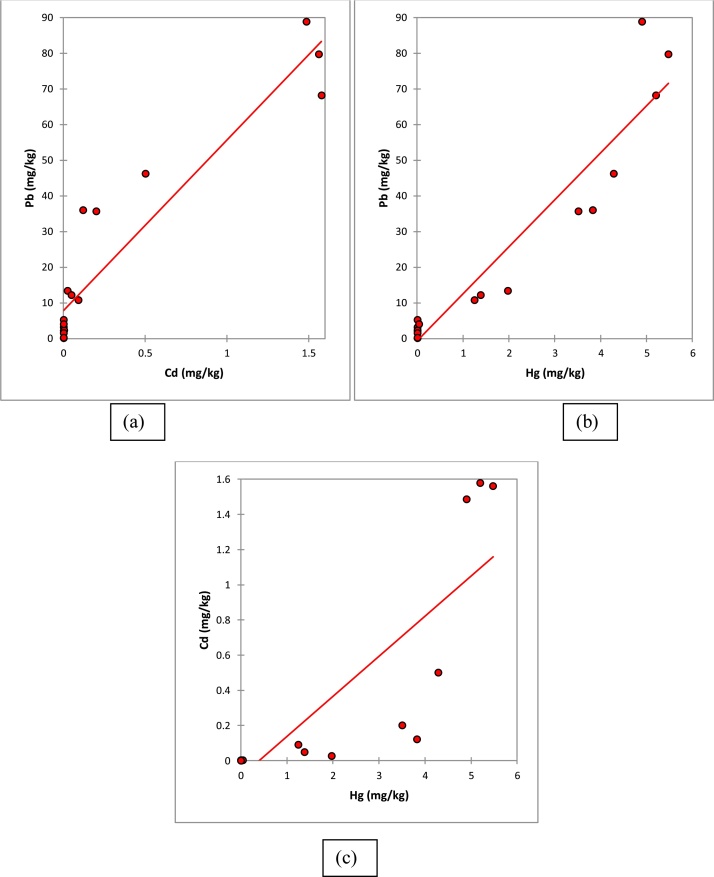
Inter-elemental correlation among toxic metals within brain of rats showed strong positive correlation (r > 0.80) between metals such as (a) Cd and Pb (b) Hg and Pb (c) Hg and Cd during the study. All correlations were significant at p < 0.01.